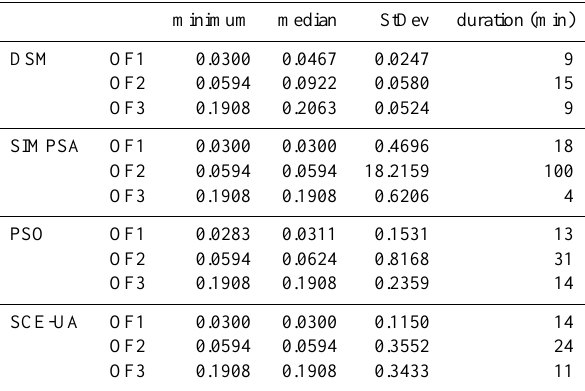
Table 3. Descriptive statistics of the performance of different opti- mization methods for the calibration of the Modified Bartlett-Lewis Rectangular Pulses